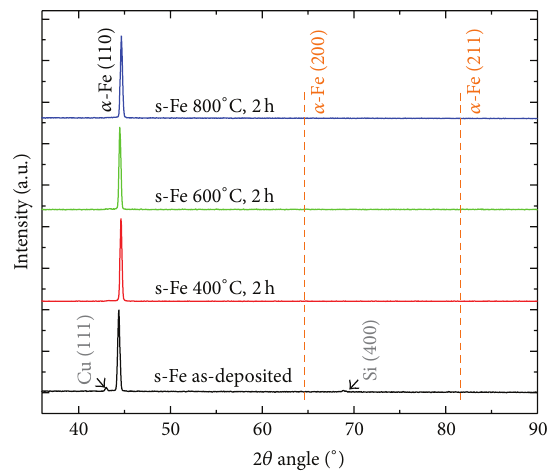
Figure 3: XRD 𝜃 -2 𝜃 scan of as-deposited and annealed s-Fe foils. Due to the preferred (110) orientation before and after annealing, only the corresponding reflection is visible. No peak shift due to stress relaxation is noticeable. Also the possible 𝛼 -Fe (200) reflection and 𝛼 -Fe (211) reflection are indicated by vertical dash